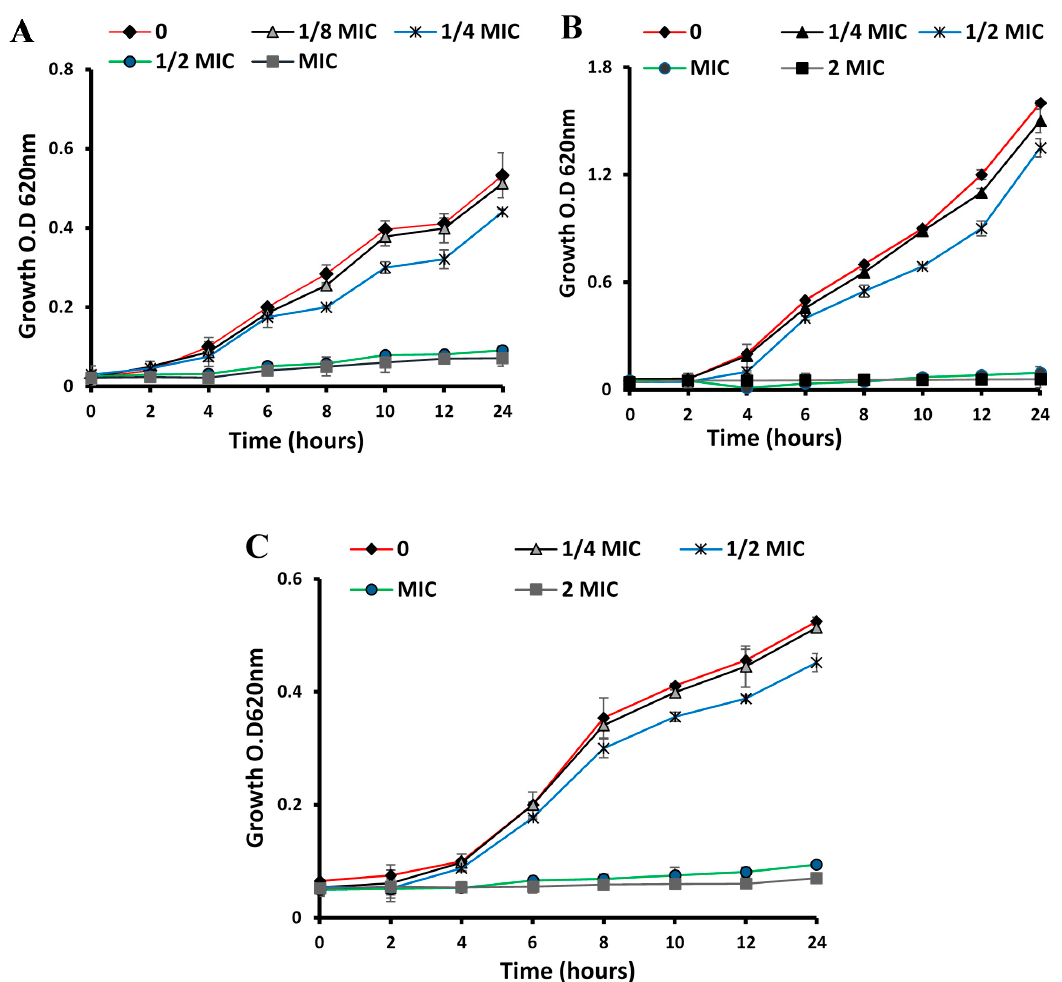
Figure 1. Time–kill curves illustrating the effect of different concentrations of E. sideroxylon flower extract on the growth of ( A ) S. aureus ACL51 (MRSA), ( B ) P. aeruginosa ATCC 27853, and ( C ) C. albicans ATCC 90028 every 2 h during the first 12 h and then after 24 h.